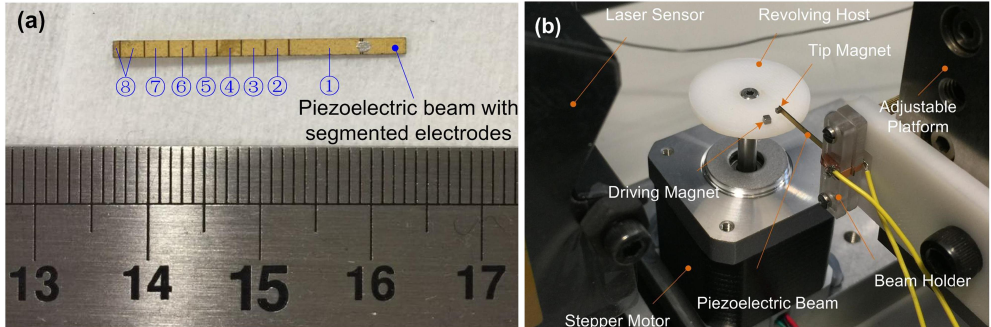
Figure 7. Piezoelectric beam with segmented electrodes ( a ) and experimental set-up ( b ).